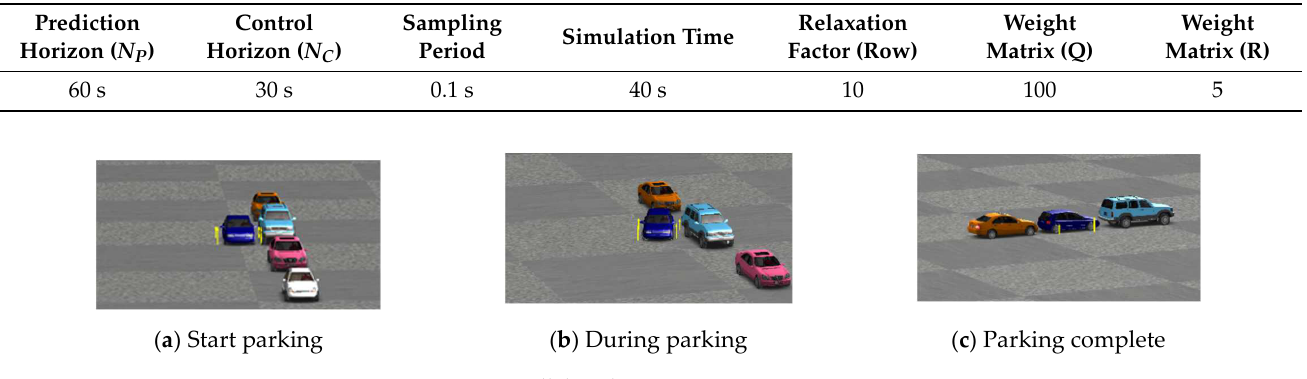
Figure 6. CarSim parallel parking scene.